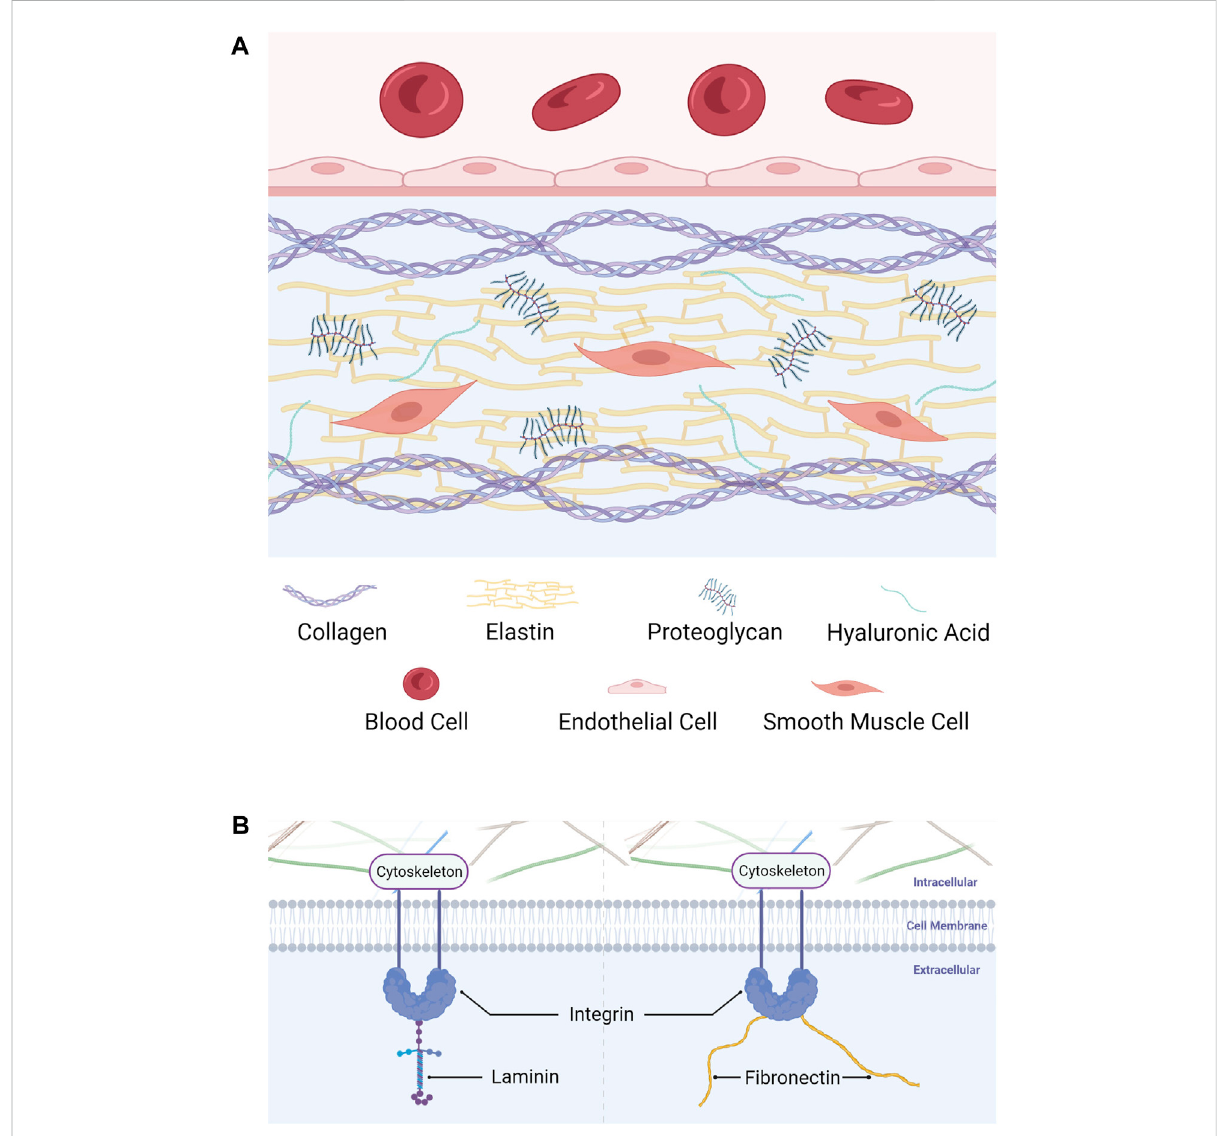
FIGURE 1 Components of the decellularized vascular matrix. (A) Structural protein and invisible gelatinous structures. (B) Linked/adhesive